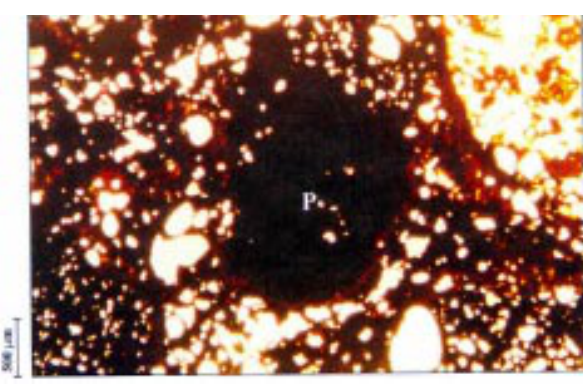
Figura 7. Petroplintita do perfil P1 mostrando parte de seu volume interno predominantemente plásmico (P). Luz normal -